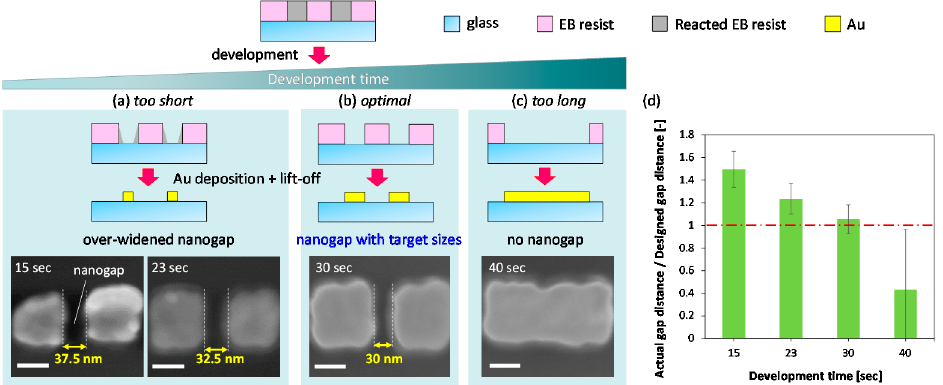
Figure 3. Schematic of influence of developing time on gap distance in the fabrication of gold nanogaps and representative SEM images of gold nanogaps fabricated at different development times, corresponding to cases of ( a ) too short (15 s and 23 s), ( b ) optimal (30 s), and ( c ) too long (40 s) development times, respectively. White scale bar is 100 nm. ( d ) Relationship between actual gap distance/designed gap distance of gold nanogaps and development time.